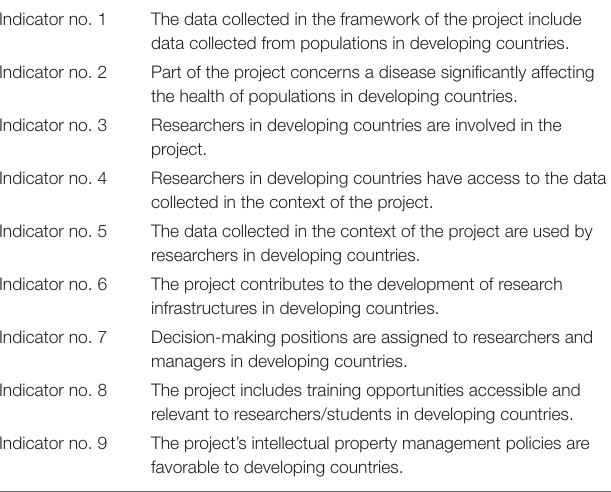
TABLE 2 | Indicators: Measuring international open science genomics projects’ performance in fostering genomic capacity building in the developing world. Indicator no.